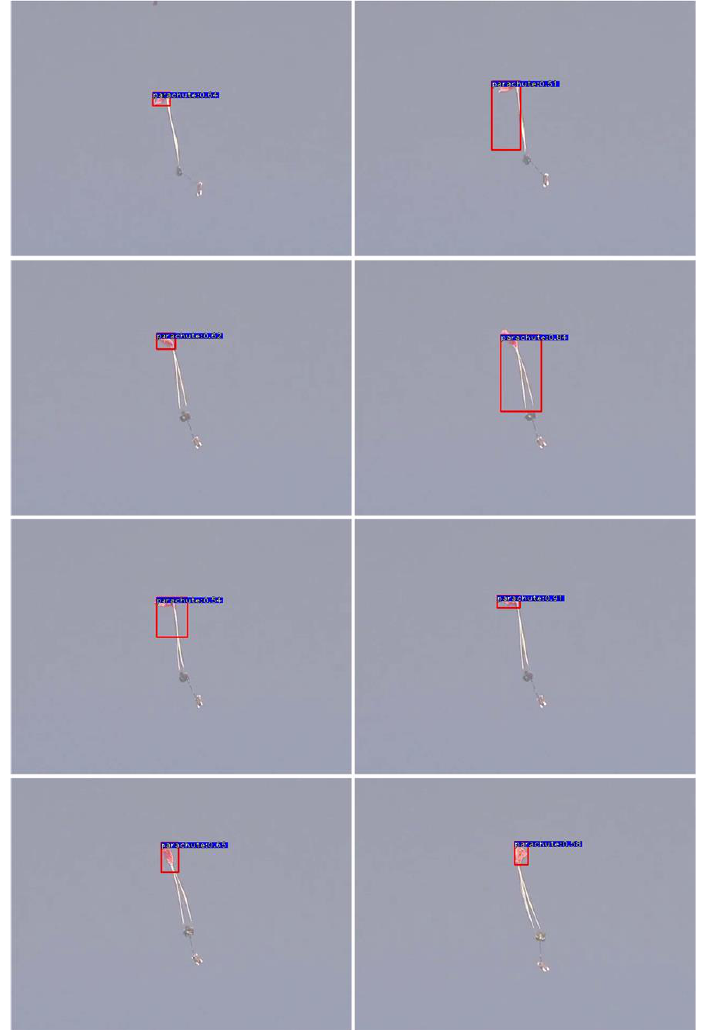
Figure 2. The detection of the continuous image sequence (timing: from left to right, top to bottom). a m × m sliding-window is used to get contextual information of each feature-patch